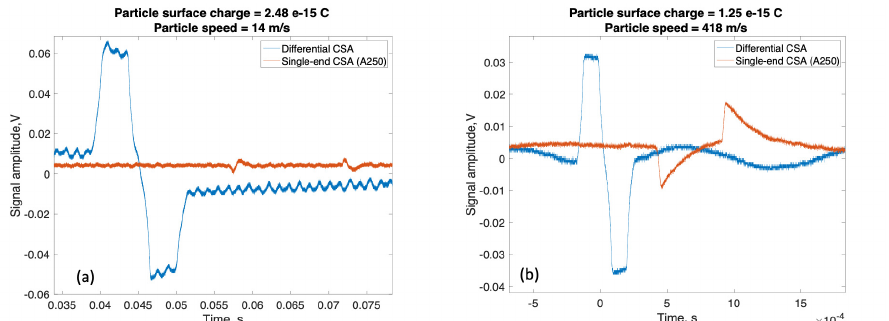
Figure 7. Typical inducted signals recorded two types of dust detectors: ( a ) one low-speed particle (14 m/s) and ( b ) one high-speed particle (418